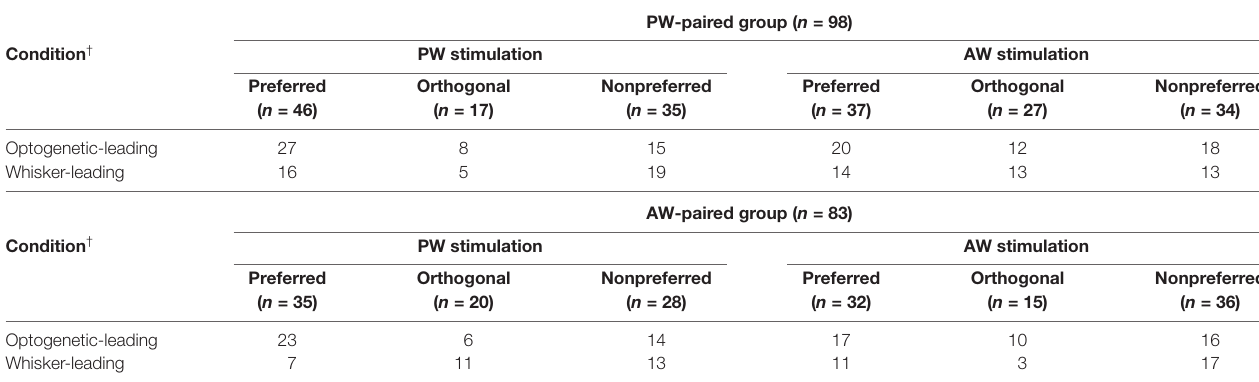
TABLE 3 | Number of single units in each condition: 2 modality sequences × 3 paired